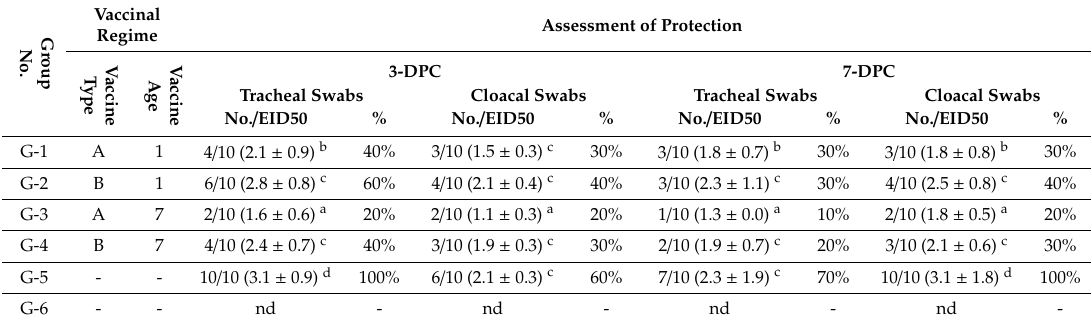
Table 6. Virus shedding at 3- and 7-days